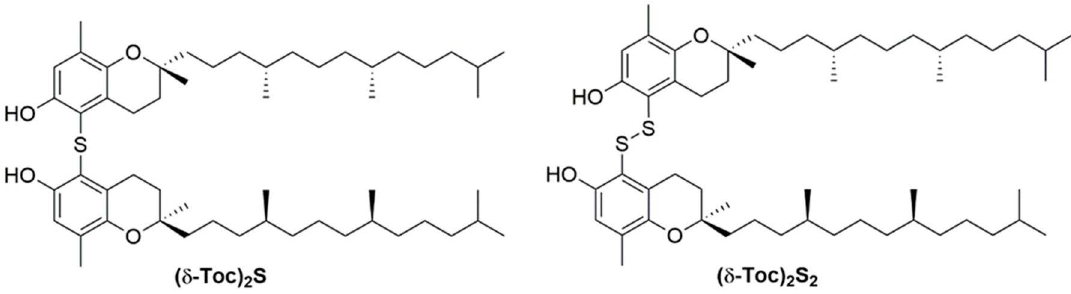
Figure 2. Structure of bis - δ -tocopheryl sulfide ( δ -Toc) 2 S and bis - δ -tocopheryl disulfide ( δ -Toc) 2 S 2 tested in this